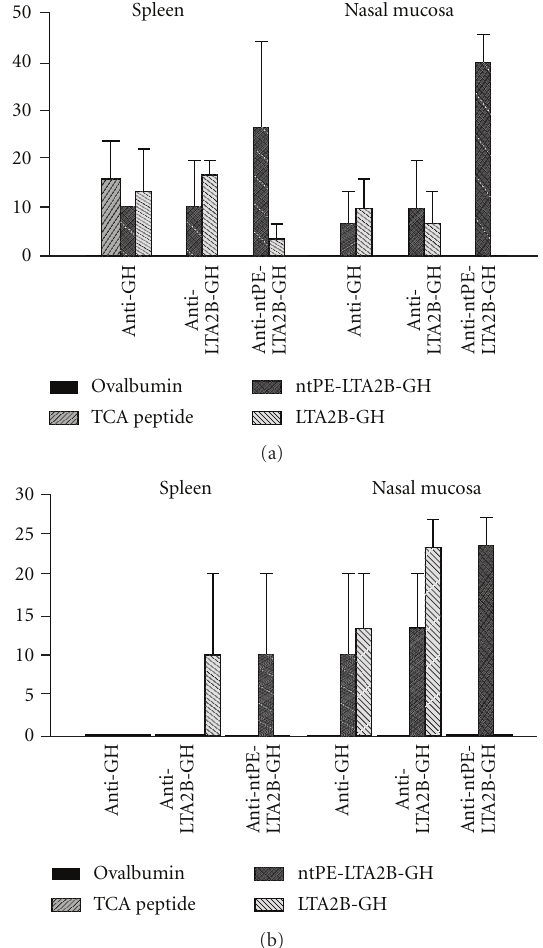
Figure 4: Enumeration of IgG and IgA antibody-secreting cells. Spleen and nasal mucosae were collected from 3 of 6 animals from each group at the conclusion of the study, and lymphocytes were collected from these tissues to enumerate IgG (a) and IgA (b) anti- body-secreting cells by ELISPOT. Y-axis represents number of ASC per million cells